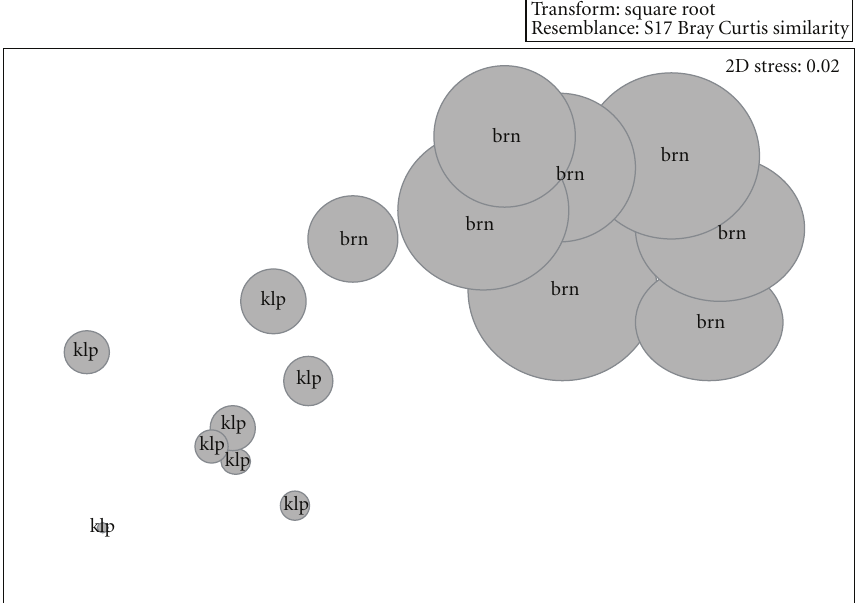
Figure 6: MDS bubble plot of the contribution of sea otter prey biomass to the separation in kelp forest and urchin barren communities in the central and western Aleutian Islands, Alaska. Bubble size scales with g · 0.25 m − 2 from remnant kelp forest (klp) and urchin barren (brn)